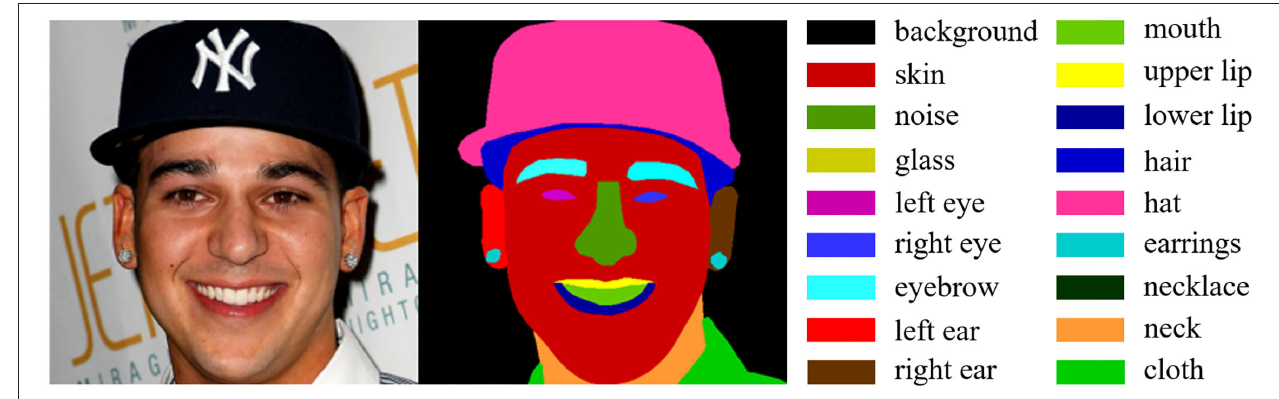
FIGURE 5 | A visual example of facial parsing map